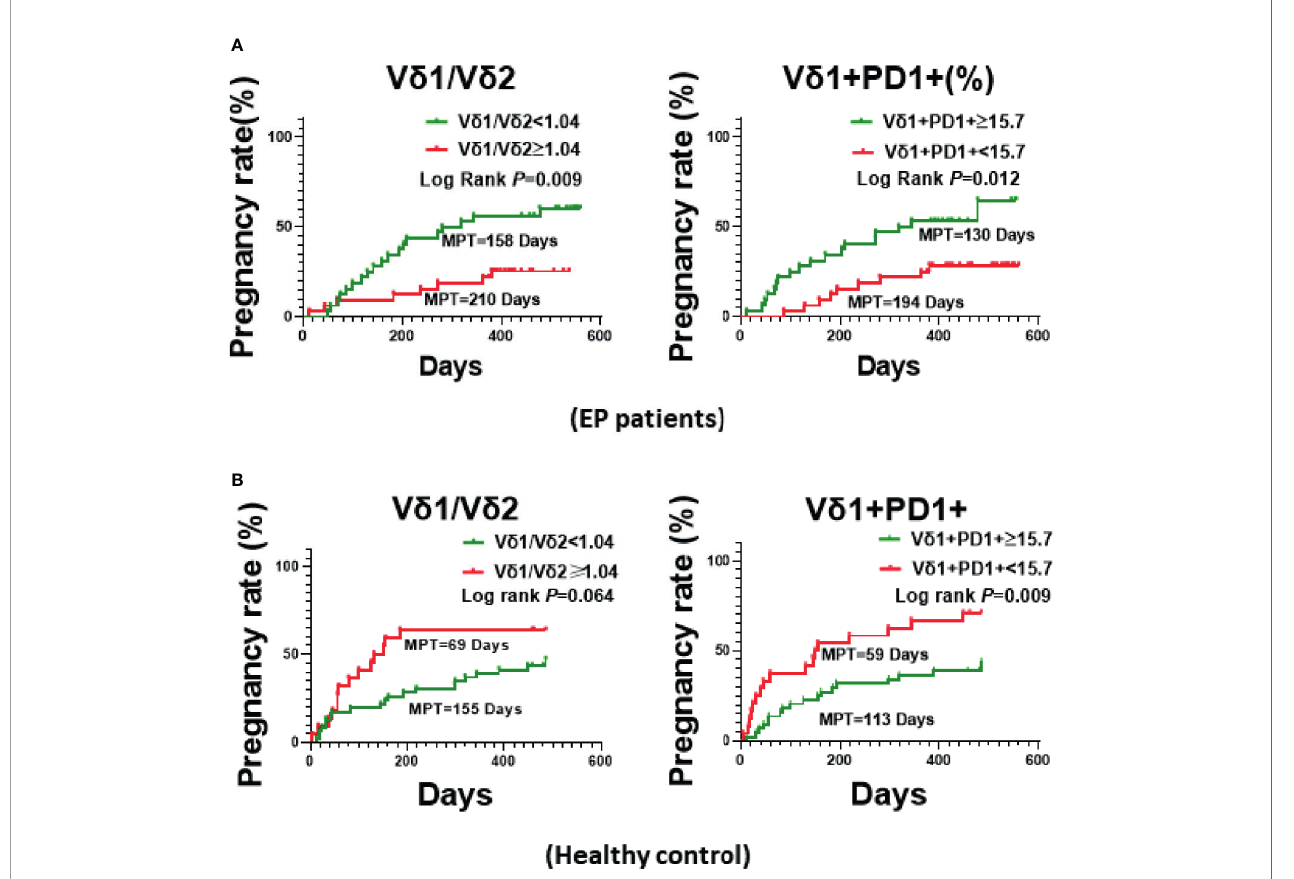
FIGURE 4 | The Kaplan-Meier Curve plotted based on the median values of V d 1 + /V d 2 + ratio or V d 1 + PD-1 + gd T cells of EP patients. (A) Comparison of pregnancy rate (MPT) between two groups with above or below V d 1/V d 2 ratio (1.04), or PD-1 expression (15.7%). (B) Comparison pregnancy rate (MPT) between healthy populations. TABLE 2 | Analysis of V d 1/V d 2, V d 1 + PD1 + gd T cells and pregnancy rate. Pregnants n